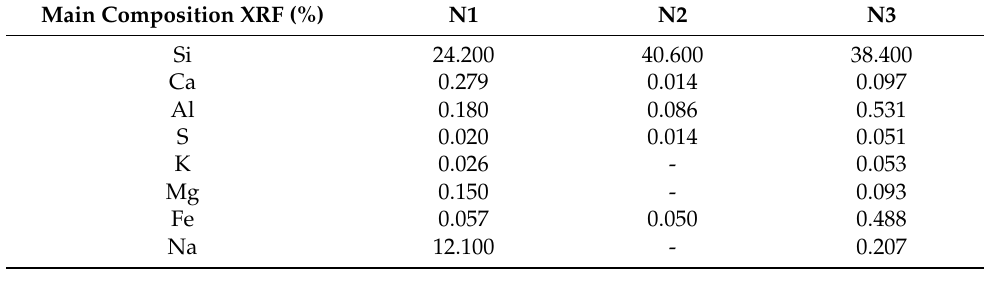
Table 3. Main composition XRF (%) of the nanomaterials.